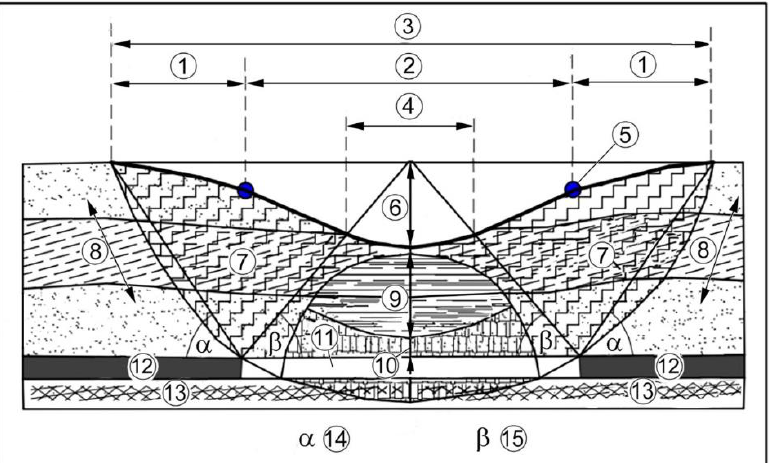
Figure 10. Subsidence trough developed by the sinking of the vault [29 – 31] (Legend: 1. tension zone, 2. warping zone, 3. original terrain, 4. sole subsidence zone, 5. inflexion point, 6. maximum subsidence, 7. deflection zone, 8. cover layers, 9. fracture zone, 10. collapse zone, 11. excavation field, 12. coal beds, 13. bedrock layers, 14. boundary angle, 15. undercut angle.